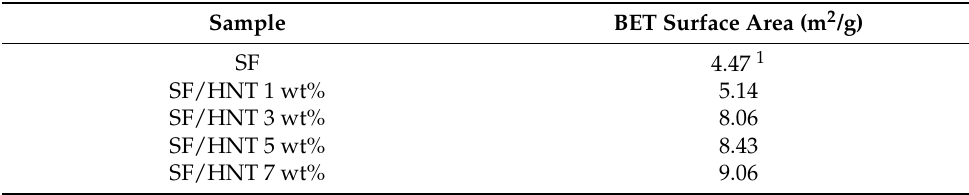
Table 1. BET Surface Area Data of—SF scaffolds and SF/HNT composite scaffolds.